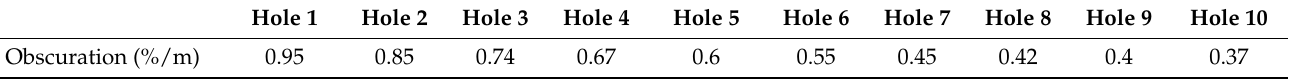
Table 3. The obscuration at ASD 1 when chamber obscuration is 5%/m. Hole